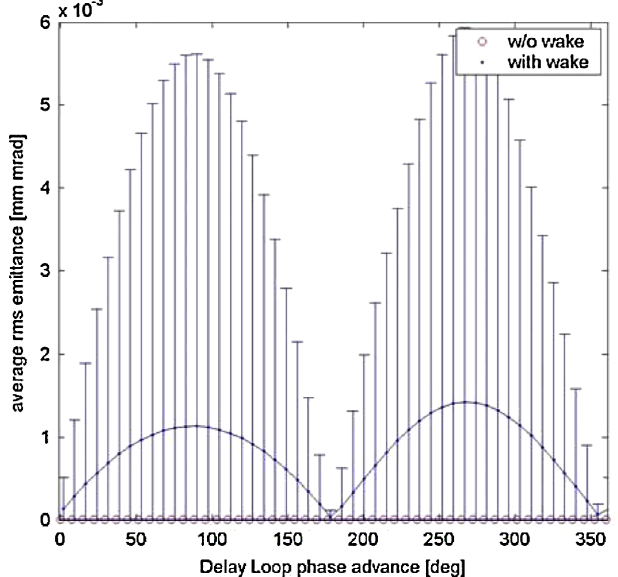
FIG. 18. (Color) The rms emittances referred to the bunch centroids without injection errors as a function of the DL phase advance. The bars indicate the maximum deviation from the mean value calculated over the train.